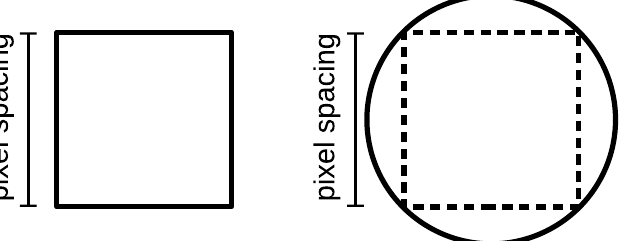
Figure 5. Difference between square ( left ) and circle ( right ) bins at the same pixel spacing resolution. To generate intensity maps, all points delimited by the chosen bin were evaluated and the largest intensity value was taken as representative for that pixel value of the matrix. In a similar way, to generate terrain and surface maps all points delimited by the chosen bin were evaluated and, respectively, the minimum or maximum height value was selected as representative of the center point of the correspondent pixel. The selection of the minimum and maximum height is illustrated of Figure 6, maximum values in blue and minimum values in red for each bin.